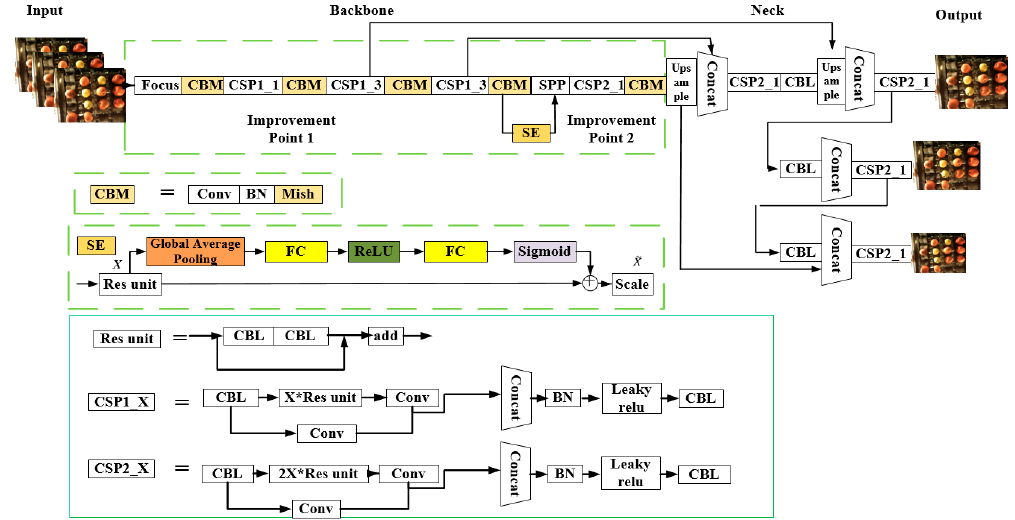
Figure 8. Diagram of the improved network structure of YOLOv5.